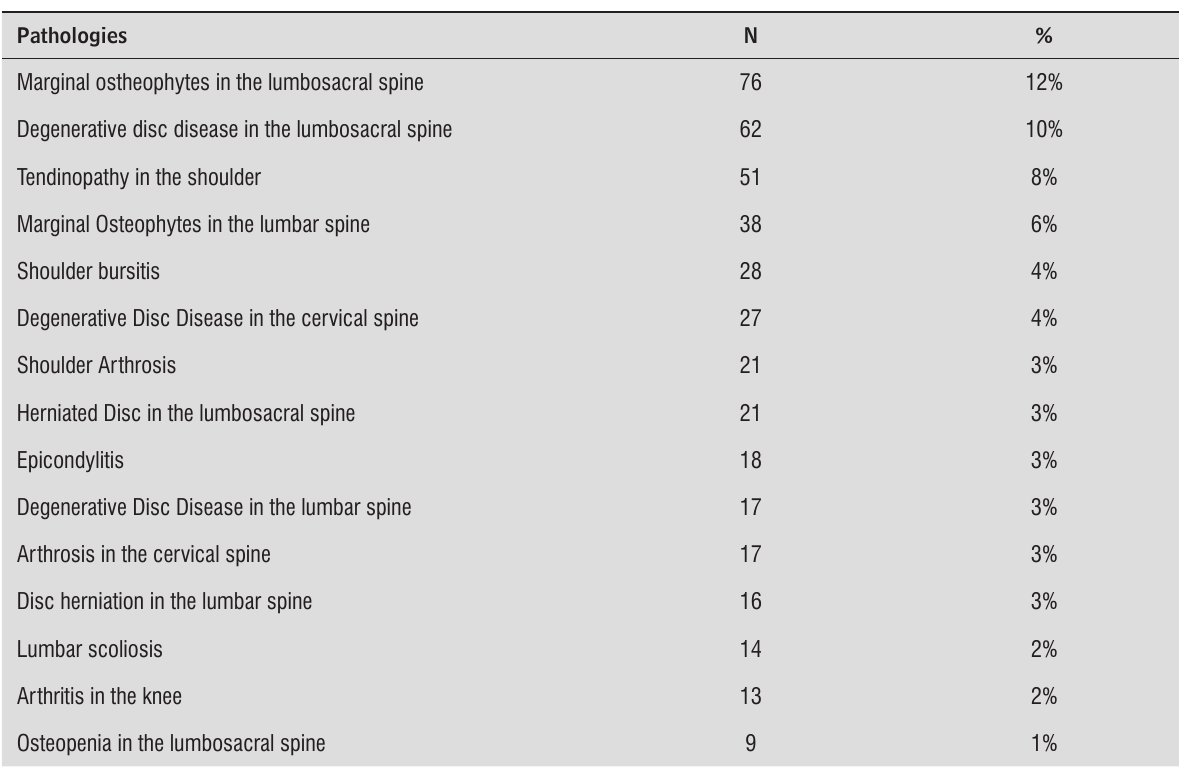
Degenerative Disc Disease in the lumbar spine Arthrosis in the cervical spine Disc herniation in the lumbar spine Lumbar scoliosis Arthritis in the knee Osteopenia in the lumbosacral